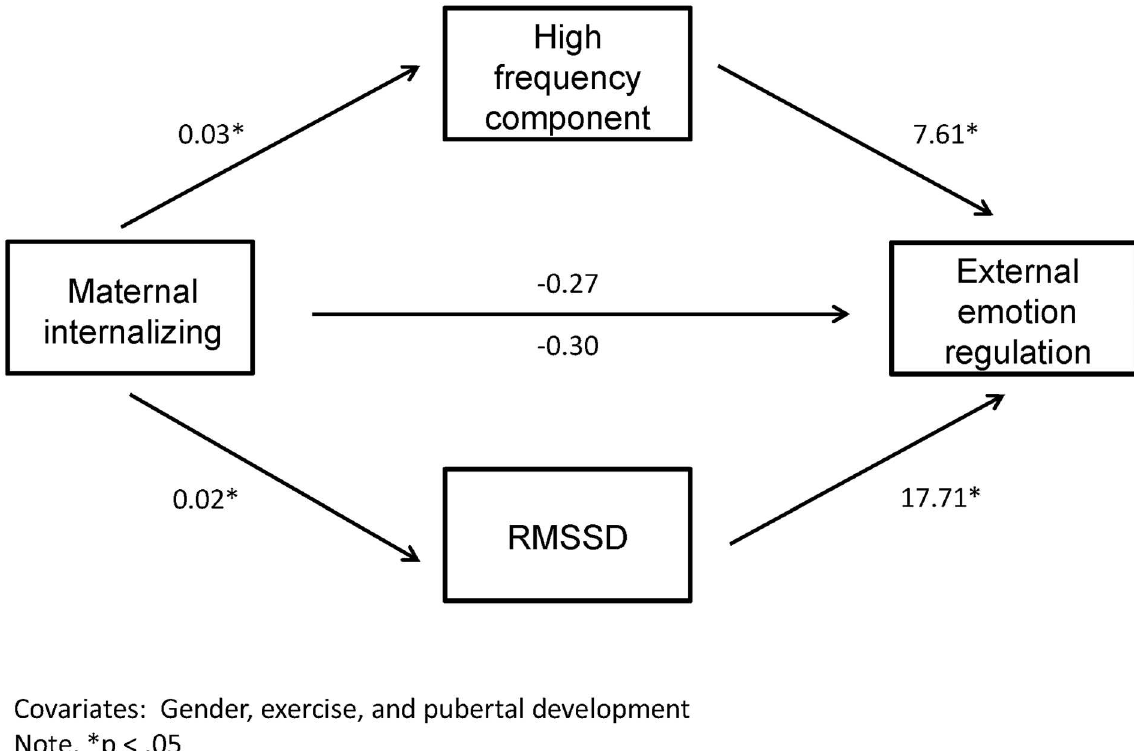
Fig 2. Visual representation of the significant indirect effect of maternal internalizing on external emotion regulation in the child through both measuresof heart rate variability (the high frequency component and